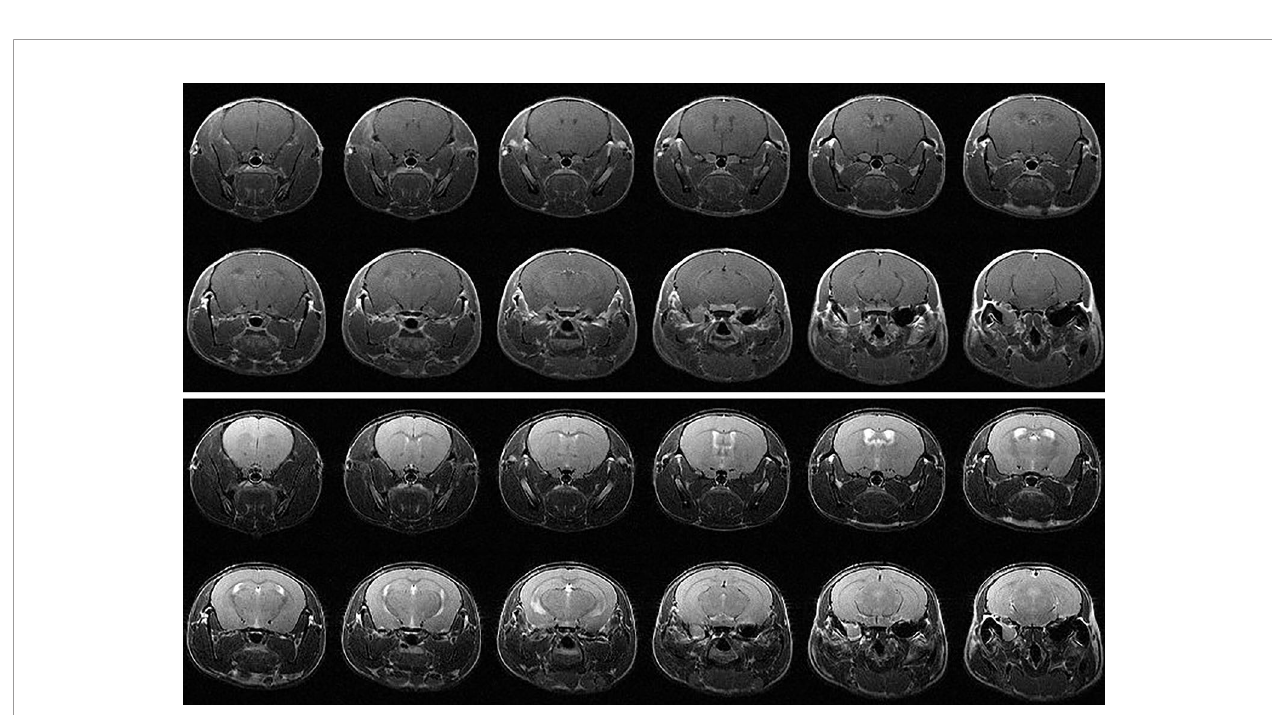
FIGURE 2 | (top) Contrast-enhanced T1-weighted and (bottom) T2-weighted MR images of a C57BL/6 mouse 10 weeks following hemispheric 30-Gy (50% isodose) GK-irradiation. Each panel shows twelve contiguous, 1-mm thick transaxial slices. Both the T1W and T2W images are indistinguishable from the corresponding images of non-irradiated mice and show no evidence of radiation-induced tissue